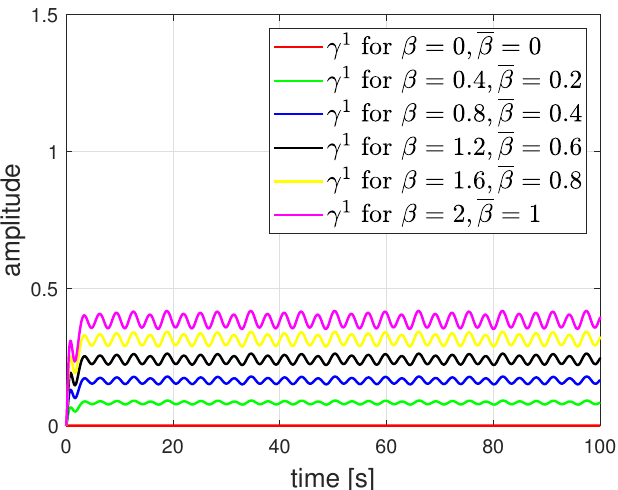
Figure 8. Residue signal of first detector when friction is considered in the detector design, but it is not accurate.